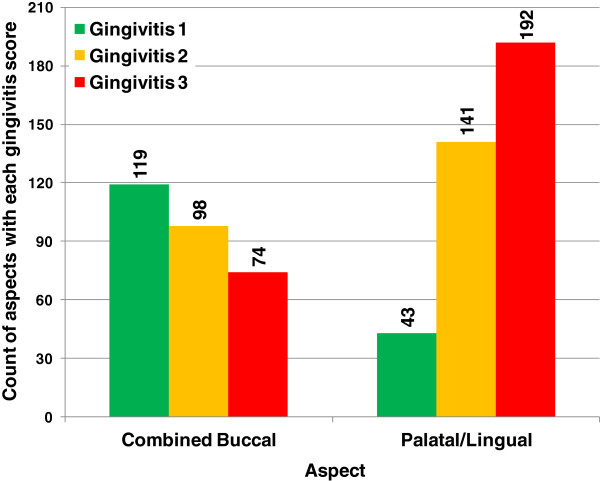
Histogram of gingivitis scores for each aspect of the tooth affected with periodontitis.